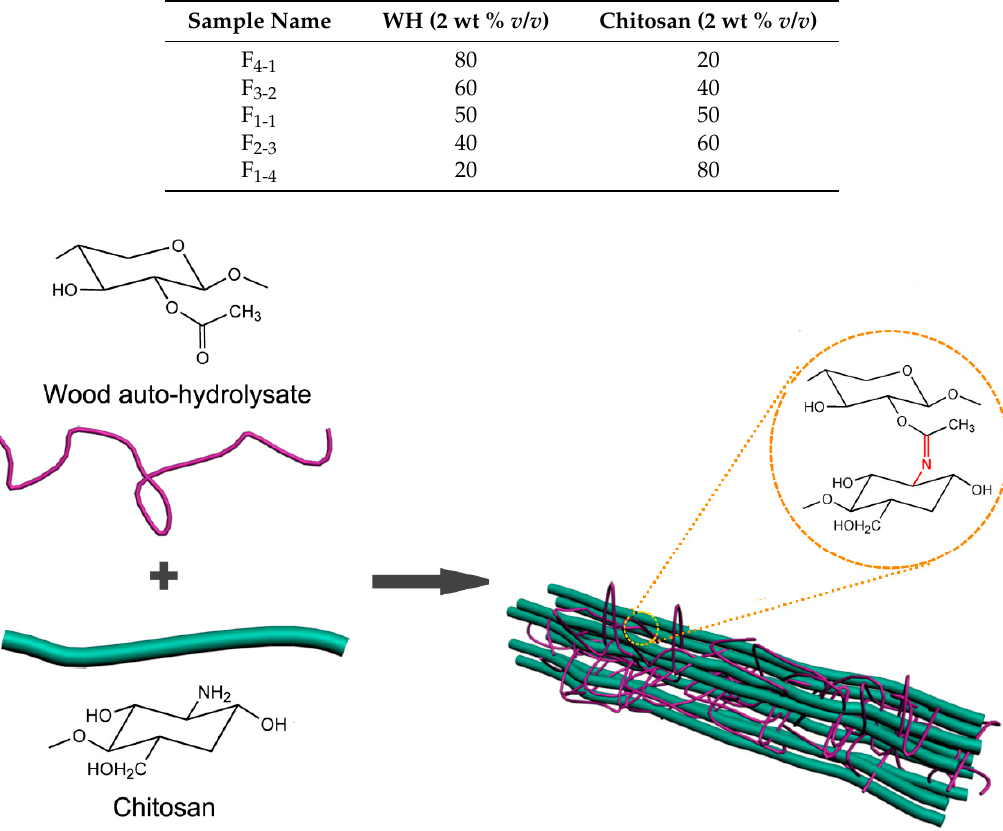
Figure 1. The forming pathway of composite films based wood auto-hydrolysates (WAH) and chitosan (CS). Table 1. Composite films with different ratios in volume of WAH and chitosan (CS).